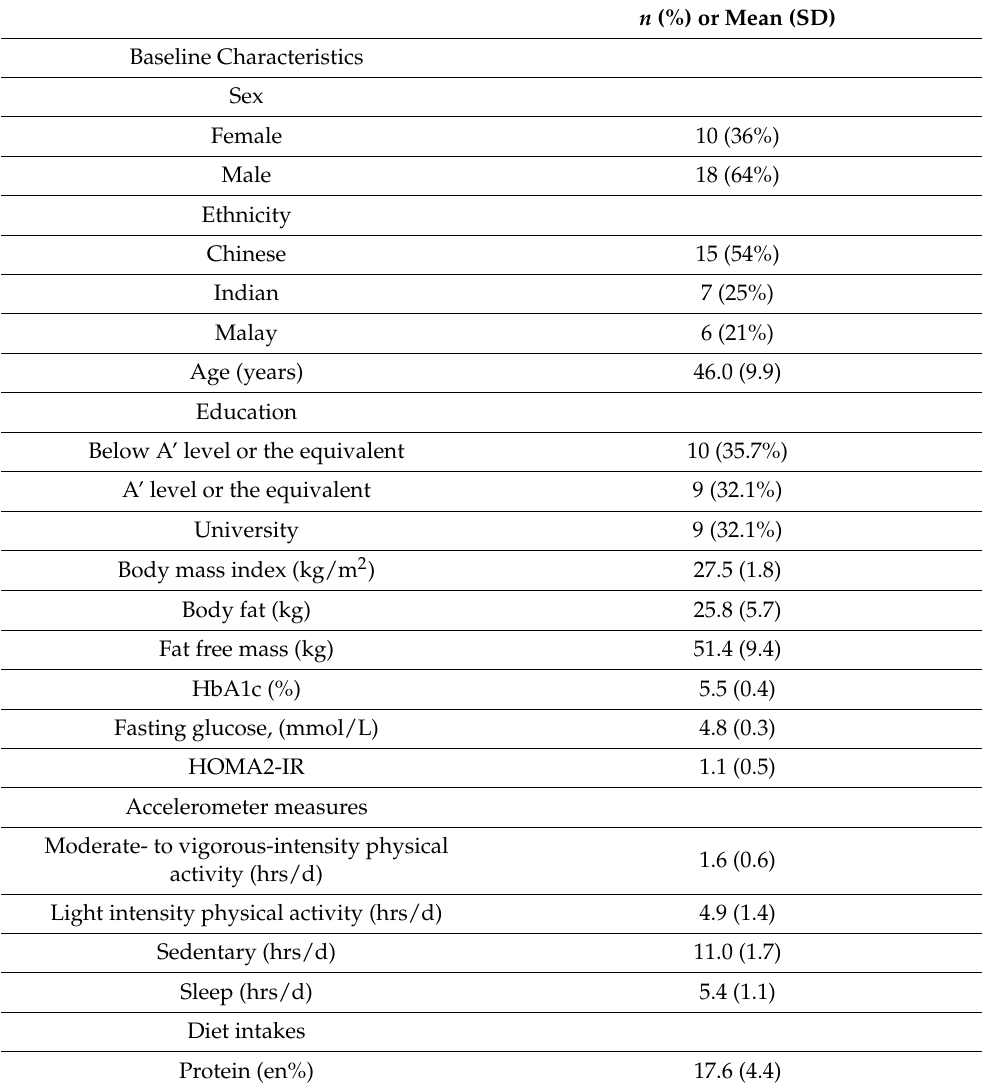
Table 1. Characteristics of study participants ( n =